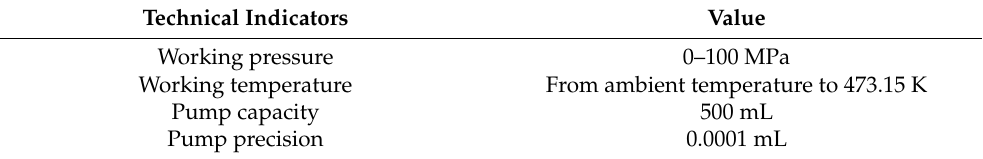
Table 3. Equipment parameters used in this